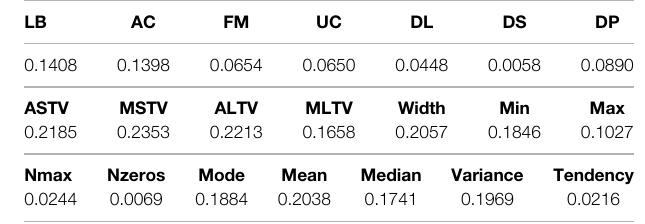
TABLE 3 | Mutual information values of attributes and